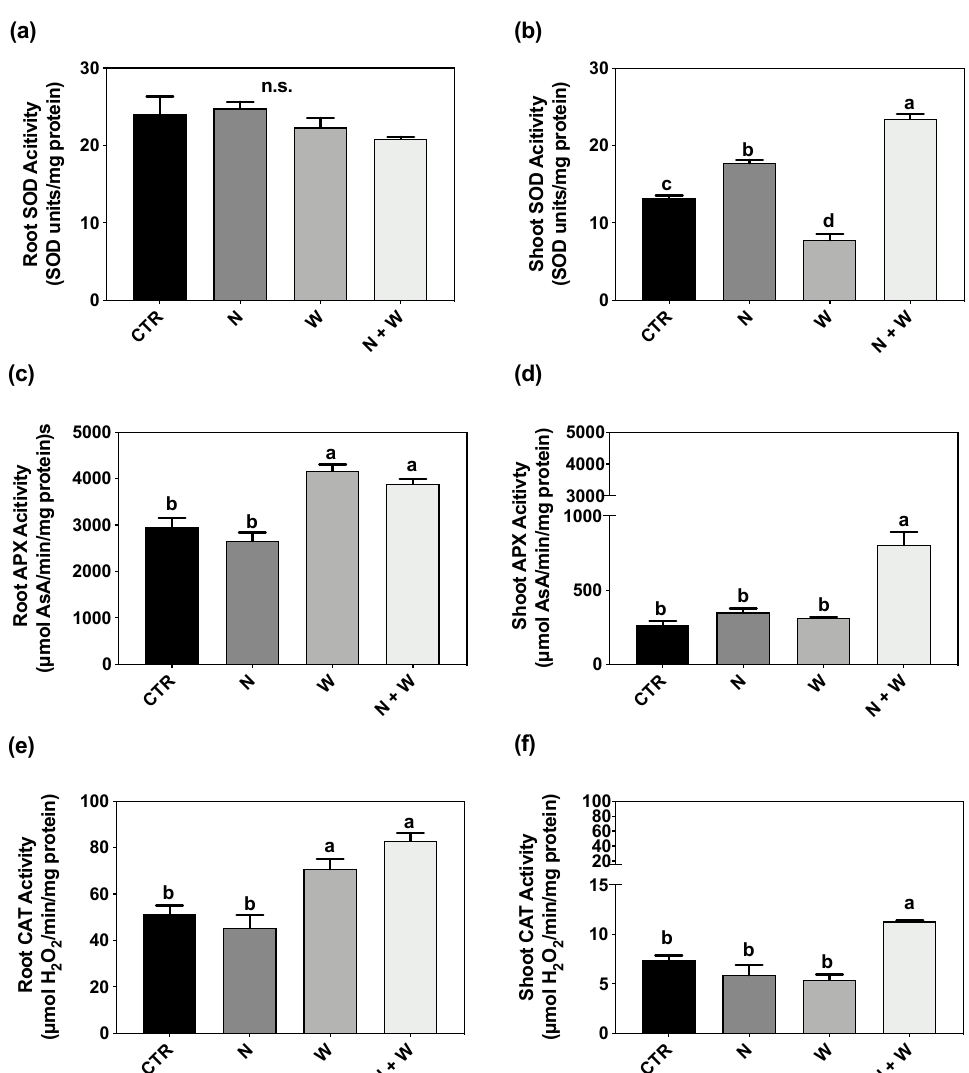
Figure 5. SOD activity in roots ( a ) and shoots ( b ), APX activity in roots ( c ) and shoots ( d ) and CAT activity in roots ( e ) and shoots ( f ) of tomato plants grown for 16 days under control (CTR; 10.5 mM N + 100% W), nitrogen deficit (N; 5.3 mM N + 100%W), water deficit (W; 10.5 mM N + 50% W) or combined nitrogen and water deficit (N + W; 5.3 mM N + 50% W). Data presented are mean ± SEM ( n = 3). Different letters above bars indicate significant differences and n.s. correspond to non- significant differences between treatments according to the Tukey’s HSD test ( p = 0.05).